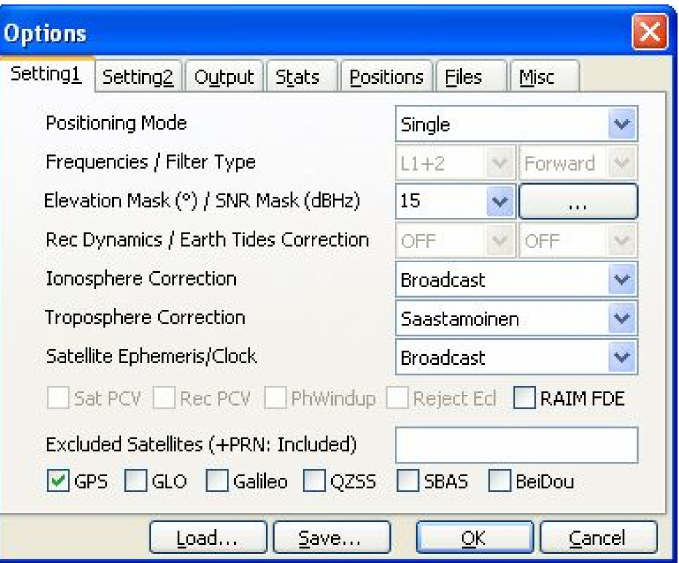
Figure 2. Software-defined RTKLIB GPS receiver settings in presented